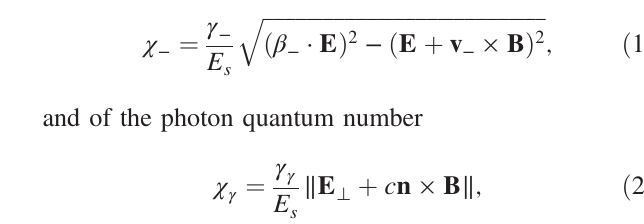
FIG. 1. All-optical setup for e − e þ pair generation. First step: a multi-GeV electron beam is created in a laser wakefield accel- erator. Second step: the electron beam collides head-on with an ultraintense, short-pulse laser pulse, leading to strong-field quantum electrodynamic emission of γ -ray photons, which in turn decay into e − e þ pairs.